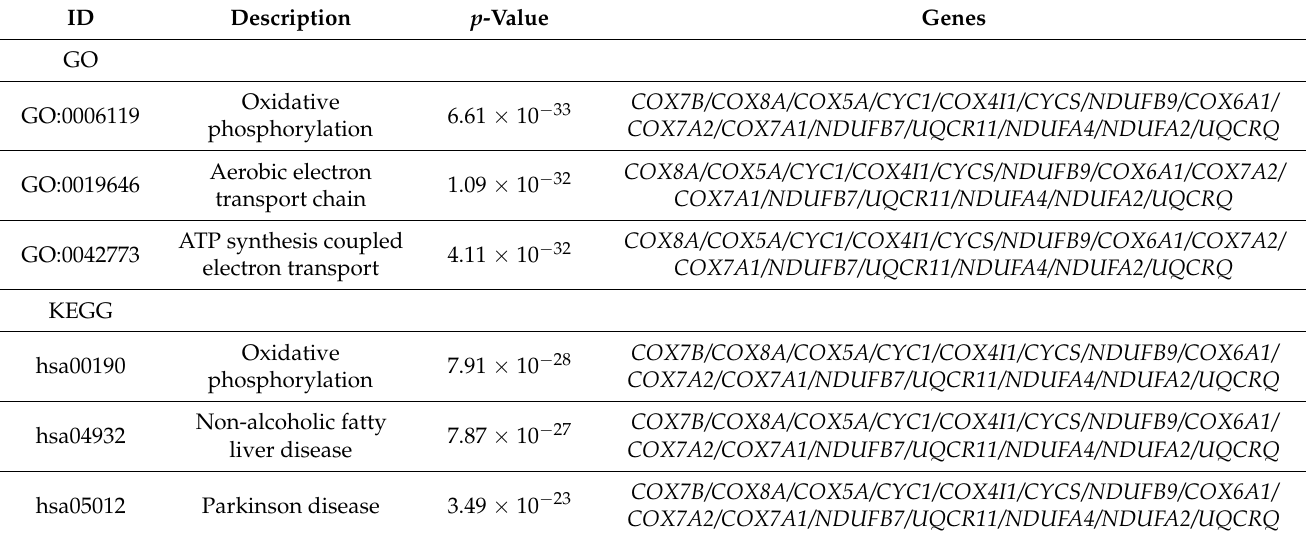
Figure 8. HMCN1 mutation-related pathways. ( A ) Multigene enrichment plot shows gene sets enriched in HMCN1 -mutant cases. ( B ) Multigene enrichment plot shows gene sets enriched in wild-type cases. ( C ) Several enrichment plots displaying a series of metabolism-related pathways. Table 1. Functional annotations of module